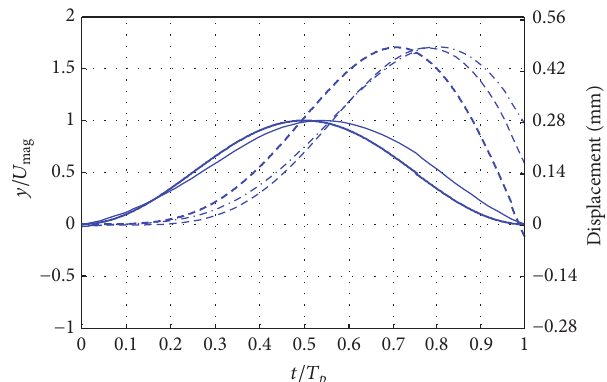
Figure 20: Displacement response of the thick secondary beam system with no friction. Thick solid line: simulation base input. Thick dashed line: response of a single-degree-of-freedom system. Thin solid line: experimental base input. Thin dashed line: response at the end of the primary beam. Thin dash-dotted line: response at the end of the secondary